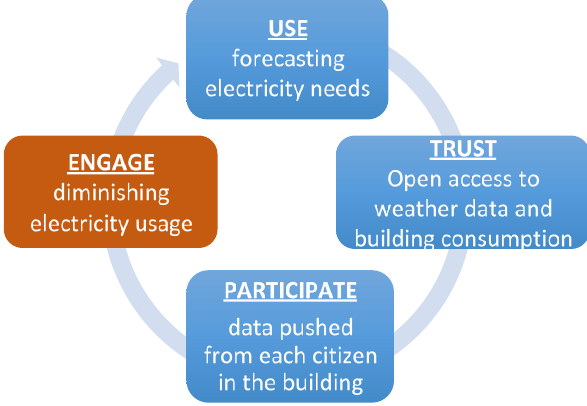
Figure 8. Prediction of renewable energy use case life cycle.